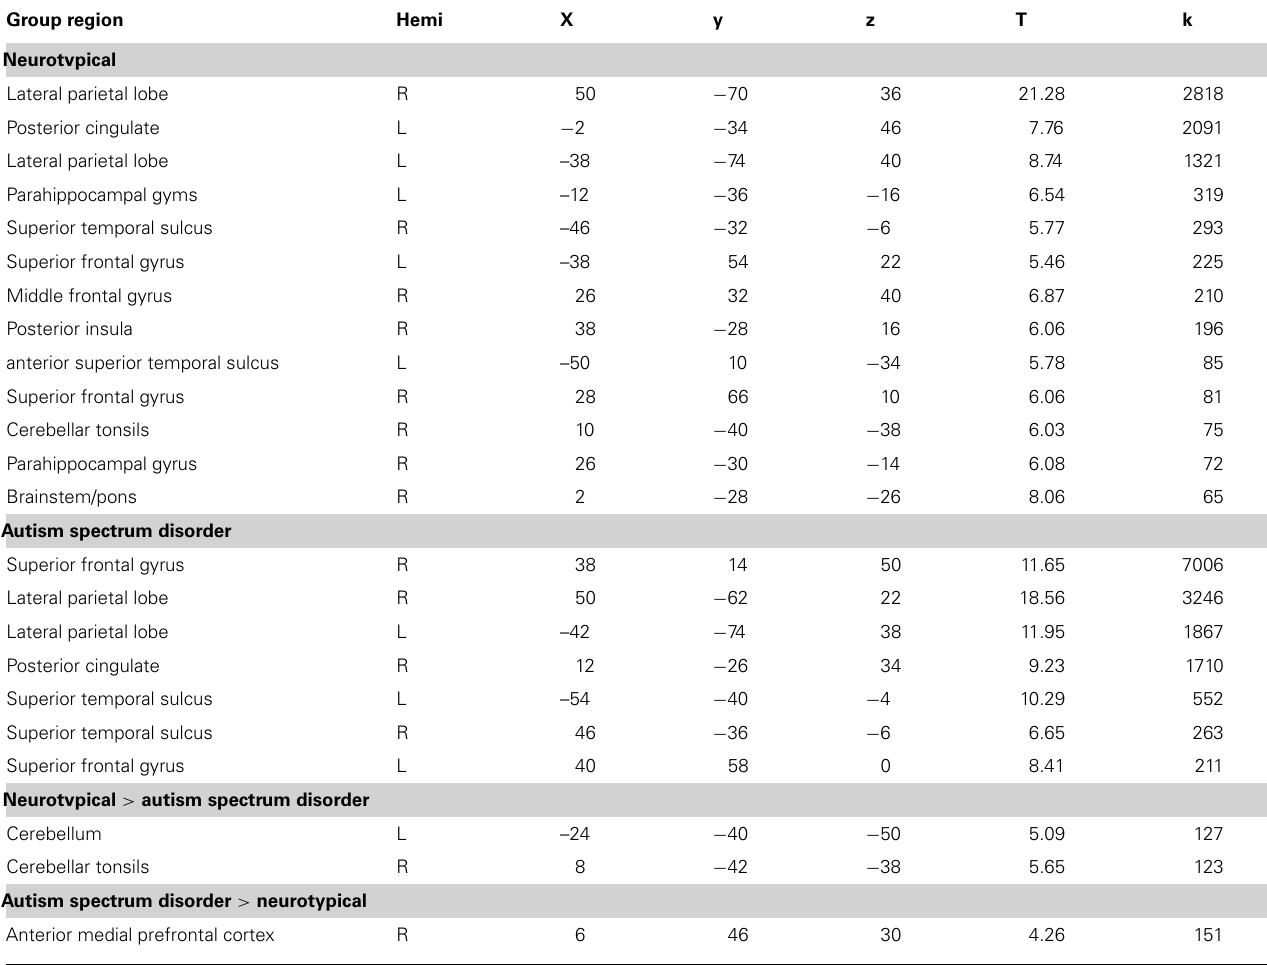
Table 3 | Functional connectivity from the right lateral parietal seed